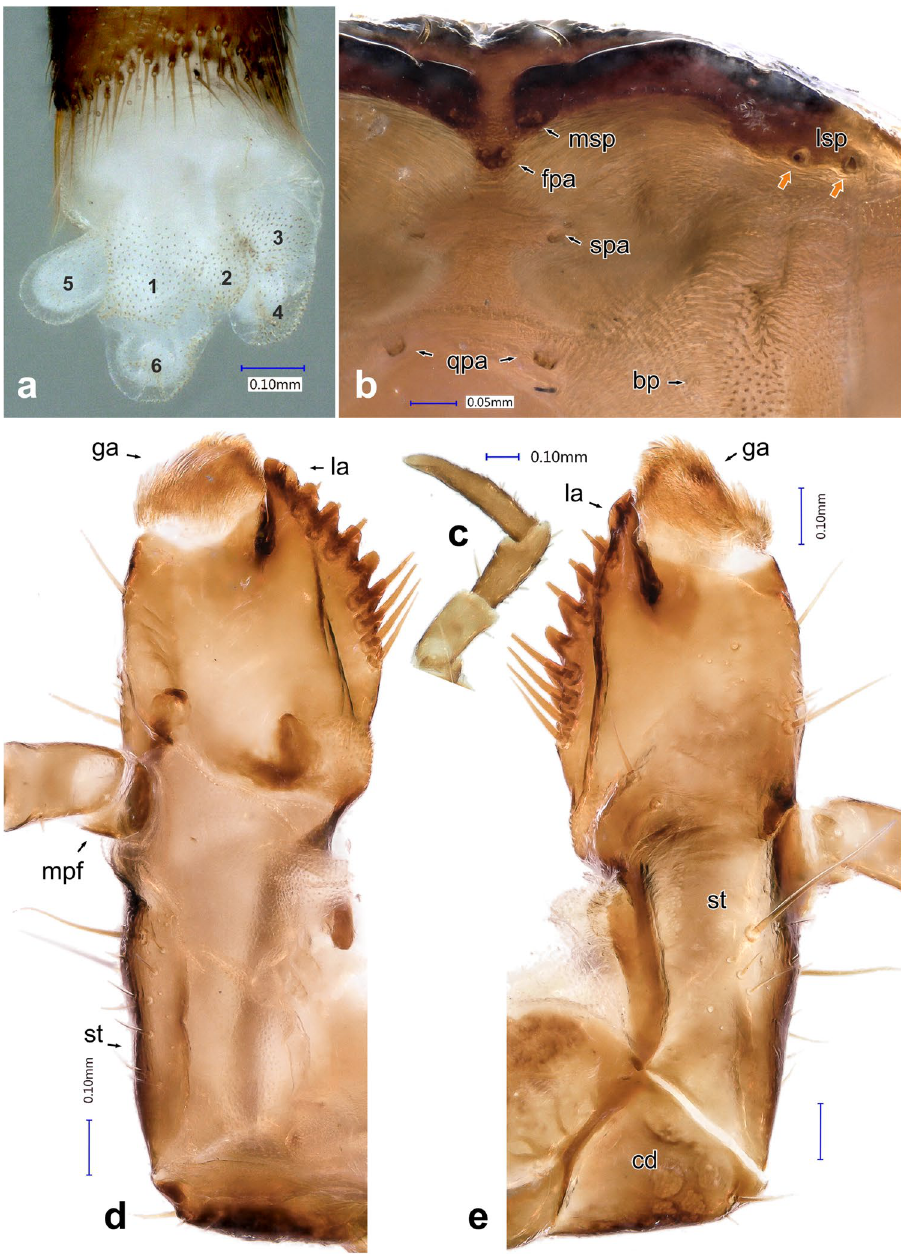
Figure 7. Heterotemna tenuicornis (Brullé, 1836), details of external morphology of larva, third instar: ( a ) segment X with six eversible lobes, ventrolateral view; ( b ) detail of epipharynx anteriorly, ventral view; ( c ) maxillary palpus, ventral view; ( d ) maxilla, dorsal view; ( e ) maxilla, ventral view. Abbreviations: bp bilobate pegs, cd cardo, fpa first porous area, ga galea, la lacinia, lsp lateral sensory pegs, mpf maxillary palpifer, msp median sensory peg, qpa quinque porous area, spa secondary porous area, st